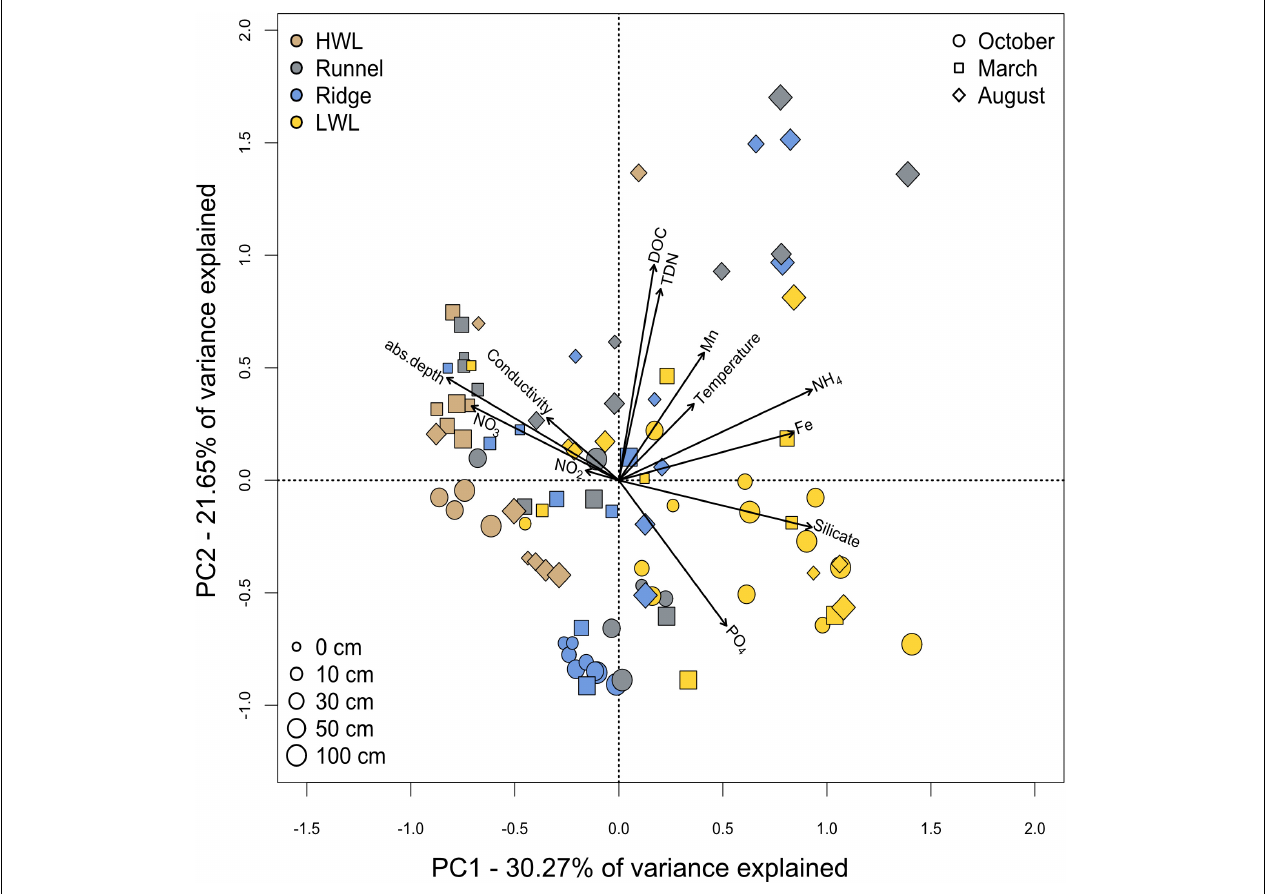
FIGURE 3 | Spatial and temporal variance of physico-chemical parameters. Porewater samples from all seasons, sites and depths were analyzed by a principle component analysis. Seasons are indicated by different symbols with varying sizes for the respective depths. The sampling sites are differentiated by color